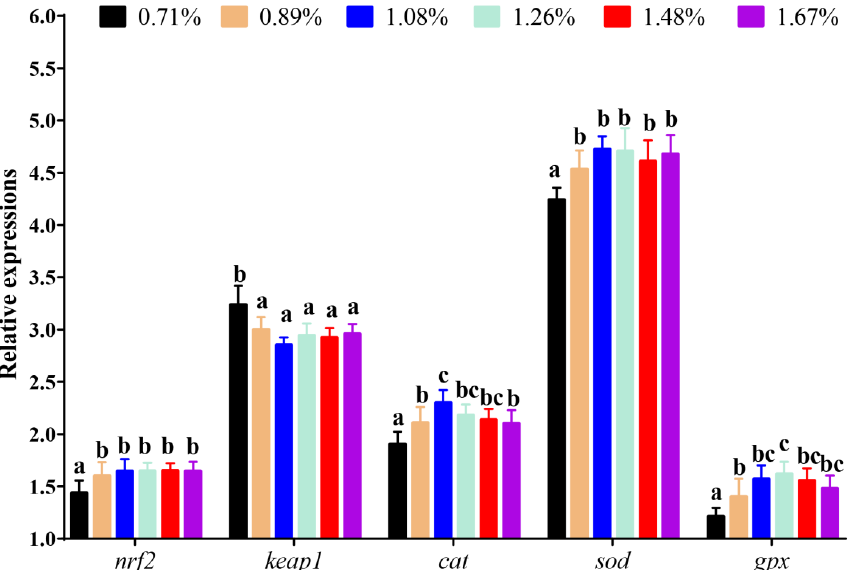
Figure 4. The mRNA levels of the key genes of the Nrf2-signaling pathway against graded different levels of dietary histidine. Data are presented as mean ± standard deviation ( n = 3 × 3). Values with different alphabetical superscripts above bars are significantly different ( p < 0.05).